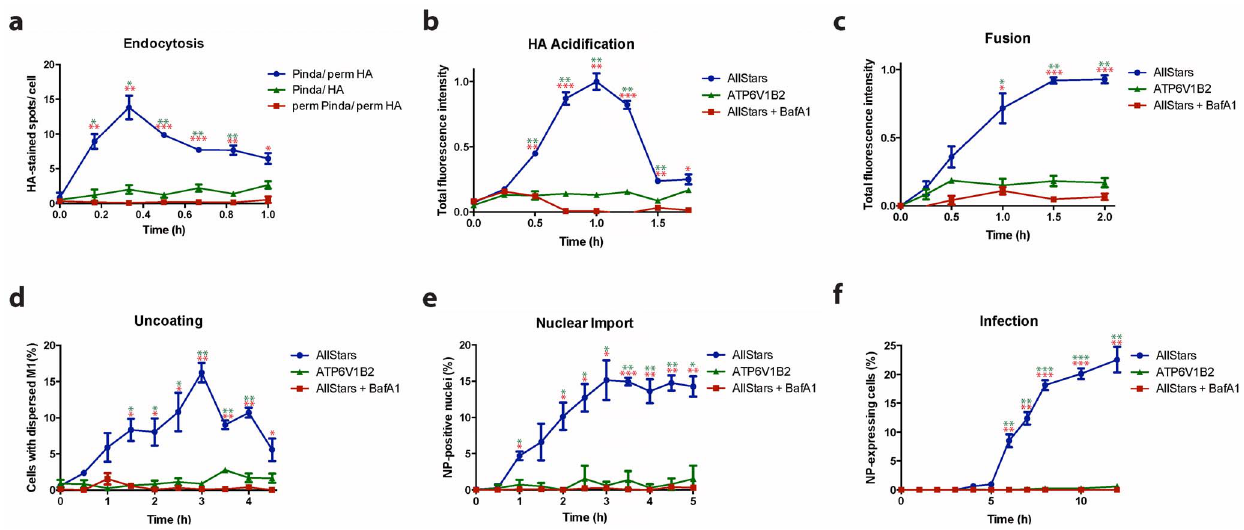
Figure 3. Time-course of IAV entry as shown by individual assays. (a) Kinetics of IAV endocytosis in the ‘Pinda/perm HA’, ‘Pinda/HA’ and ‘perm Pinda/perm HA’ cells. Endocytosed IAV signal in the ‘Pinda/perm HA’cells peaks at 20 min post-infection. (b) Acidification time-course in the cells treated with AllStars negative and ATP6V1B2 siRNAs, and the cells treated with 50 nM Bafilomycin A1 (BafA1) to block endosomal acidification. The acidification signal in the AllStars negative siRNA-treated cells reaches the peak at 1 h post-infection. (c) Kinetics of viral fusion, which shows the dequenching signal from DiOC18(3) in the AllStars negative siRNA-treated cells peaks at 1.5 h post-infection. (d) Nucleocapsid uncoating time-course indicating the peak of M1 dispersal signal is at 3 h post-infection. (e) Nuclear import time course shows that the import plateaus at 3.5 h post- infection in the control cells. (f) Kinetics of infection (transcription and translation of NP), which shows that the optimal time for the detection of cells with newly synthesized NP is 8 h post-infection. Z’ factor values are represented by * - between 0 and 0.5; ** - between 0.5 and 0.8; and *** .